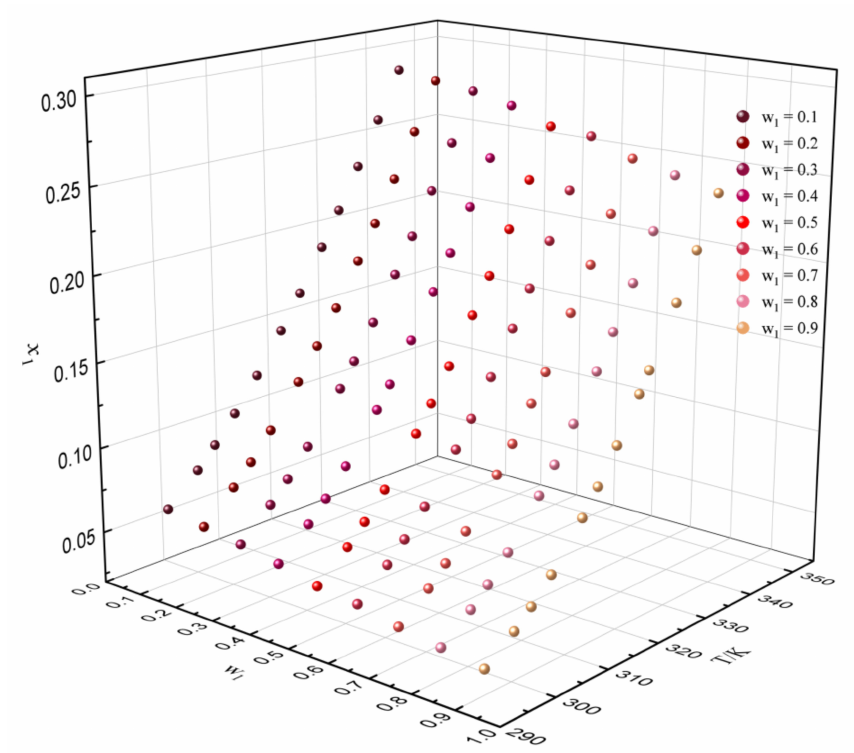
Figure 11. Solubility prediction data of dehydroabietic acid in the binary solvent of ( − )- α -pinene